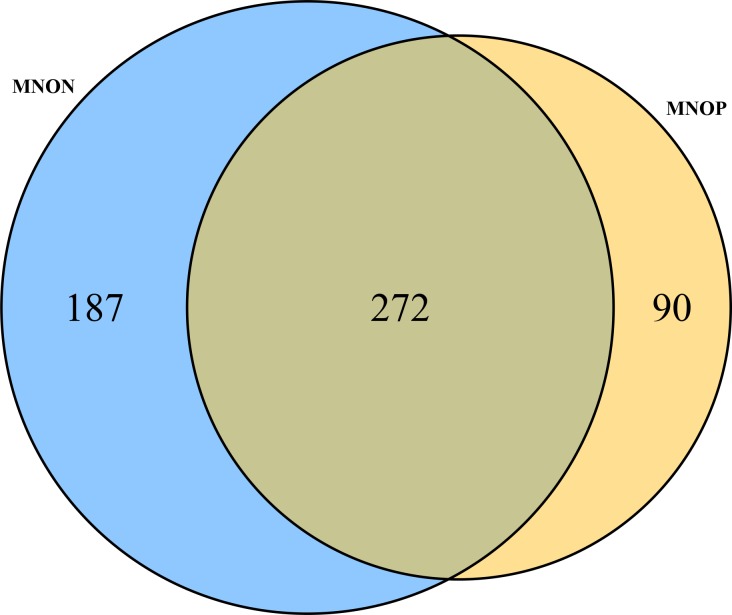
Venn diagram for exclusive DEGs found in MNON and MNOP.The number of the shared DEGs are in the cross area, while the number of the specific DEGs are in the single area.